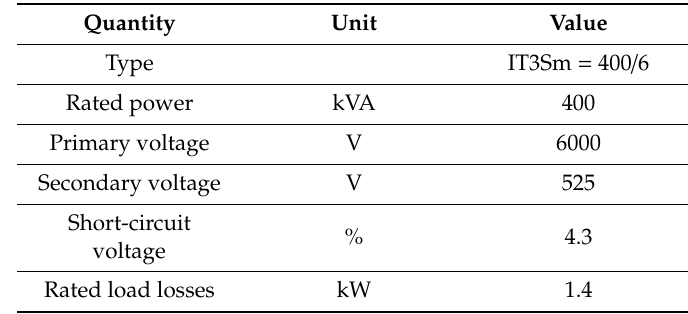
Table 3. Parameters of the flameproof mobile transformer station used for the supply of the analyzed ventube fan drive.